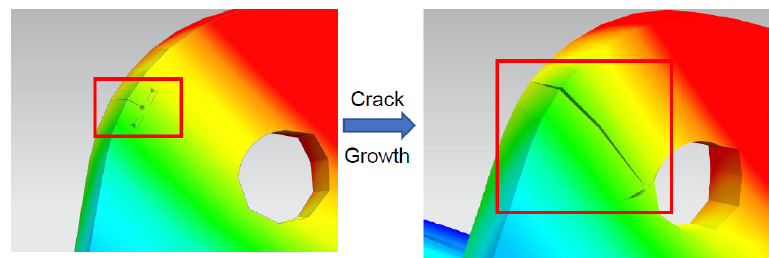
Figure 19. Through side hole crack growth behavior.